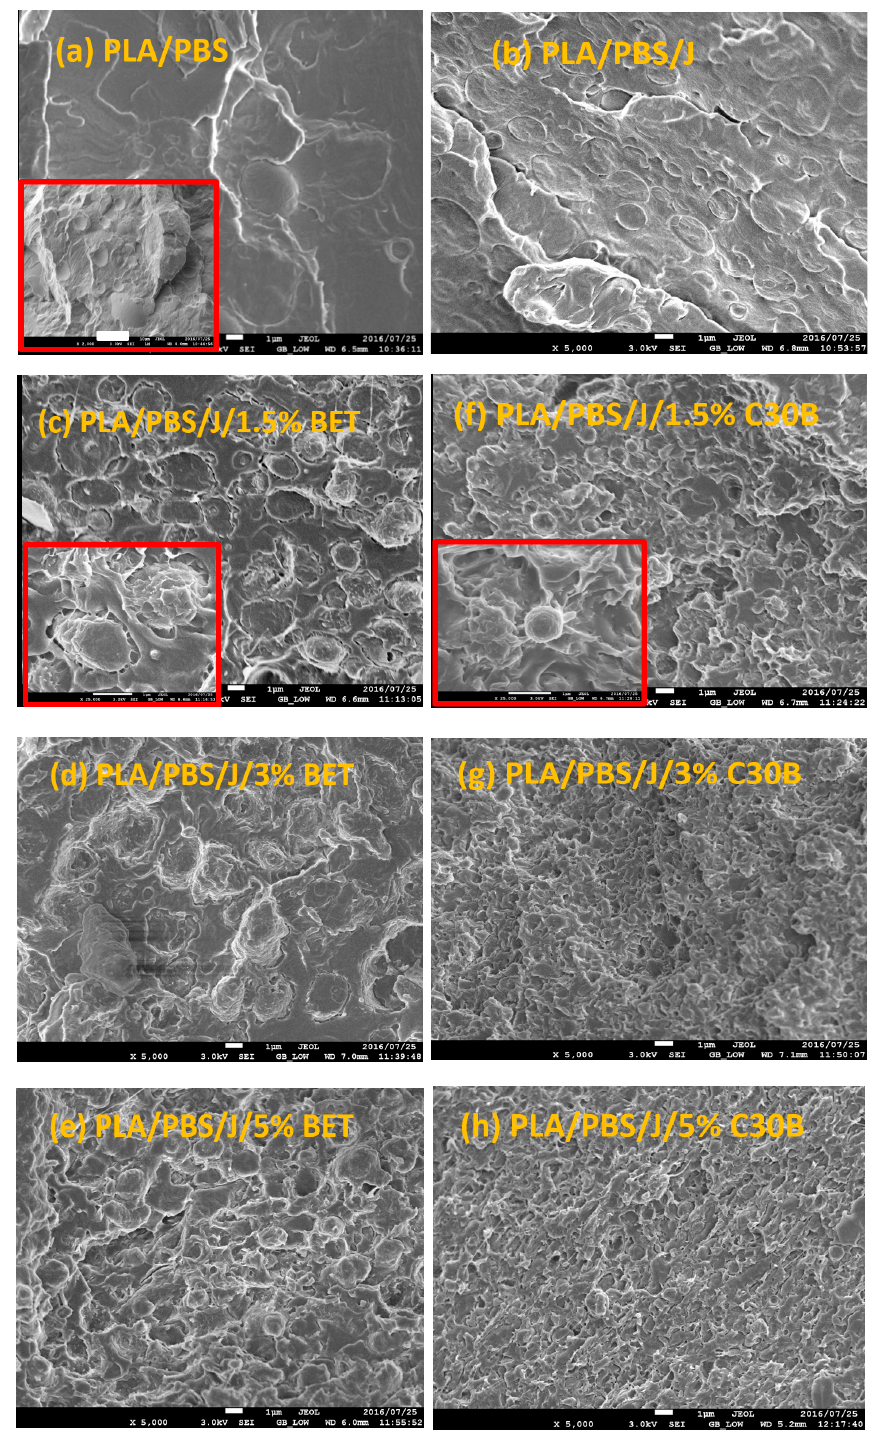
Figure 2. SEM images of ( a ) PLA/PBS, ( b ) PLA/PBS/J, ( c – e ) PLA/PBS/J/BET, and ( f – h ) PLA/PBS/J/C30B blends. The scale bars are 1 µm in all images. The scale bar in the inset image in ( a ) is 10 µm. The inset images in ( c , f ) are magnified showing two individual droplets in 1.5 wt % BET and C30B filled blends. BET is Betsopa™, C30B is Cloisite ® 30B, and J is Joncryl.